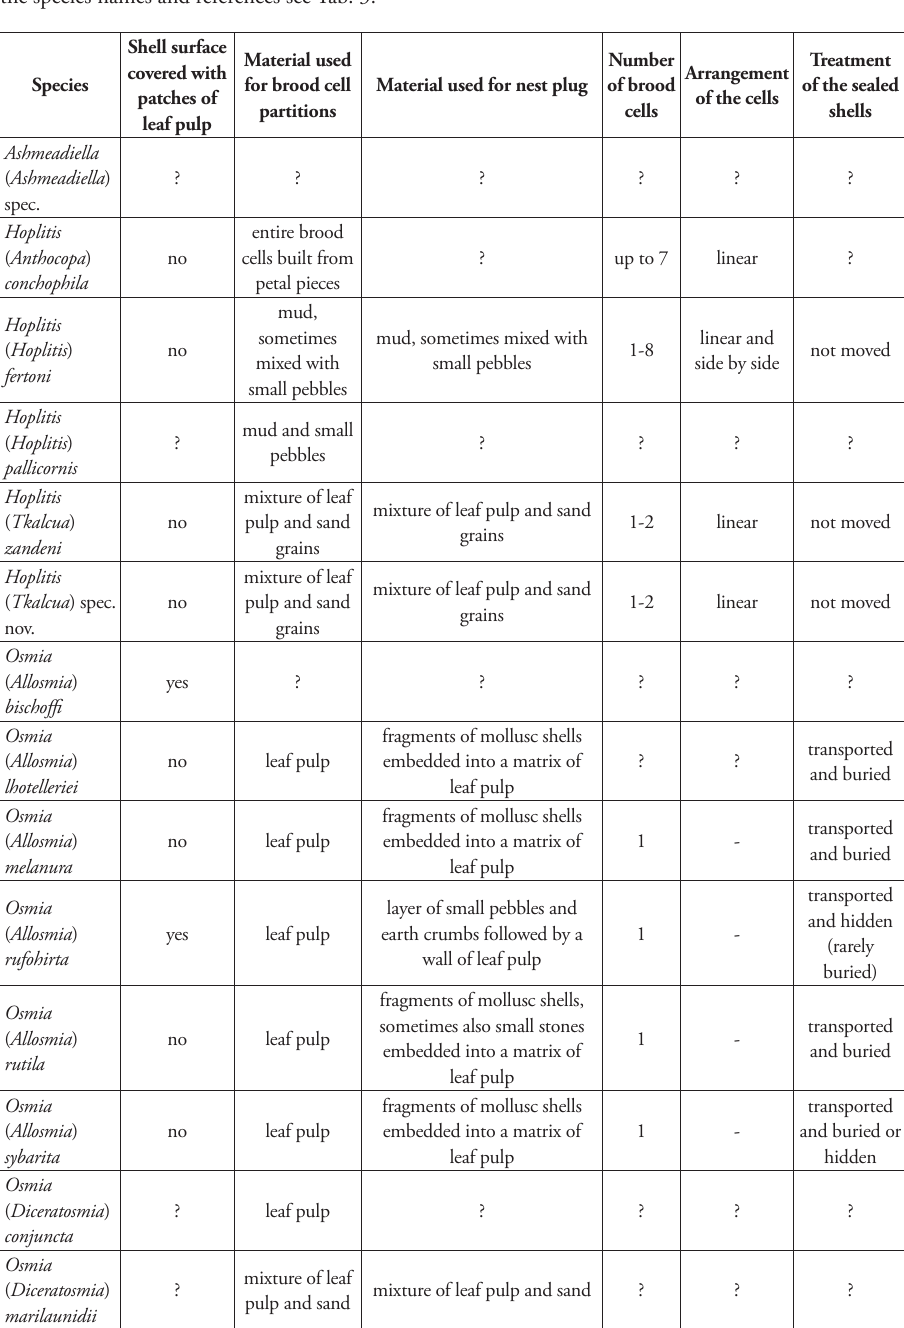
Table 4. Nest characteristics of osmiine bee species recorded to nest in empty snail shells. For authors of the species names and references see Tab.